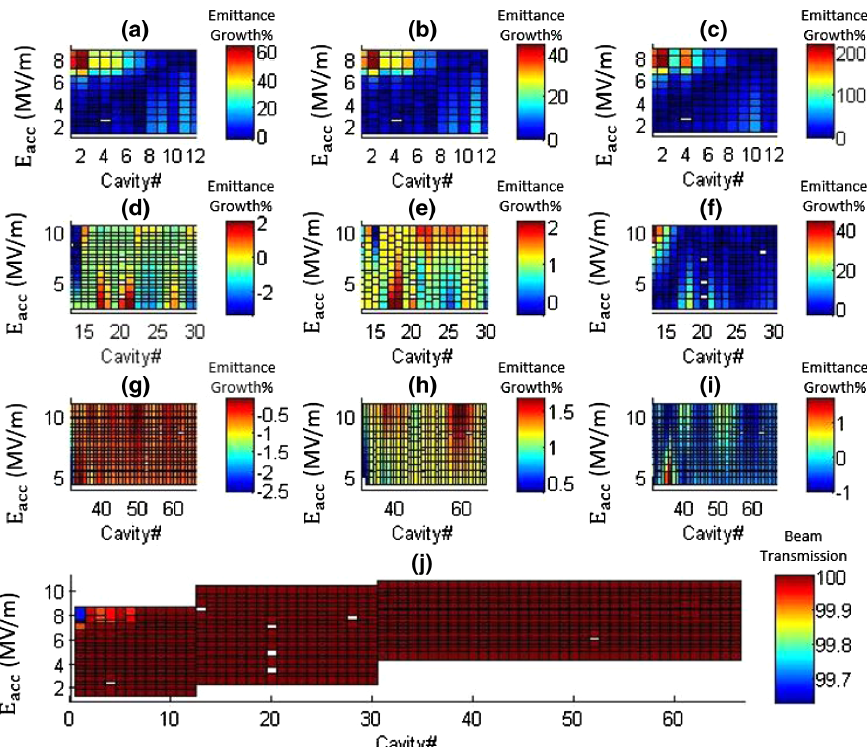
FIG. 43. (a),(b),(c) variation of X, Y, and Z emittance as a function of accelerating gradient for SSR-A; (d),(e),(f) variation of X, Y, and Z emittance as a function of accelerating gradient for SSR-B;(g),(h),(i) variation of X, Y, and Z emittance as a function of accelerating gradient for SSR-C; (j) beam transmission as a function of accelerating gradient for SSR-A, SSR-B, and SSR-C sections of the